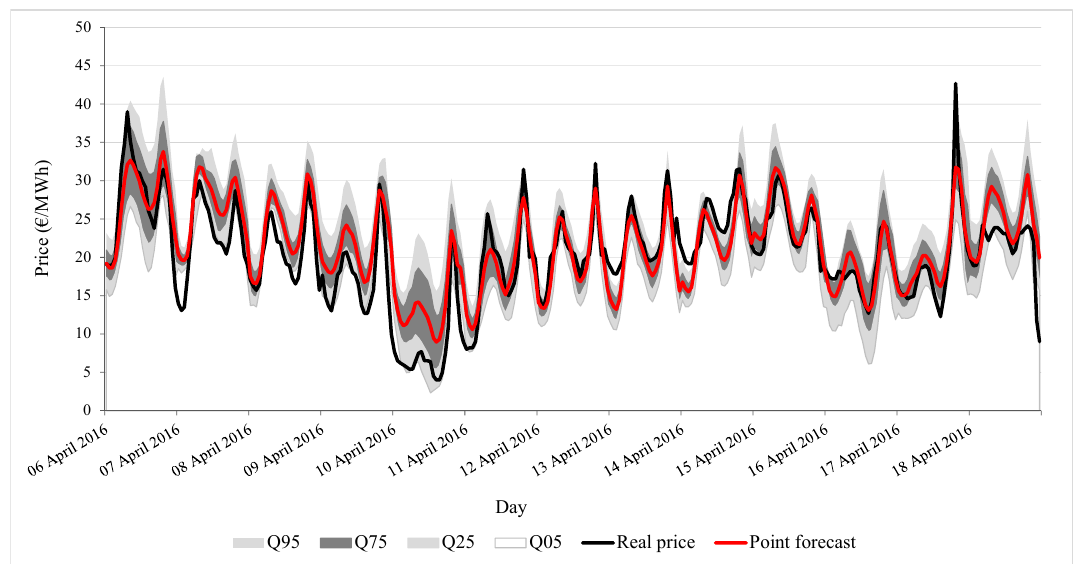
Figure 14. Probabilistic forecasts provided by PPFMCP model 2.